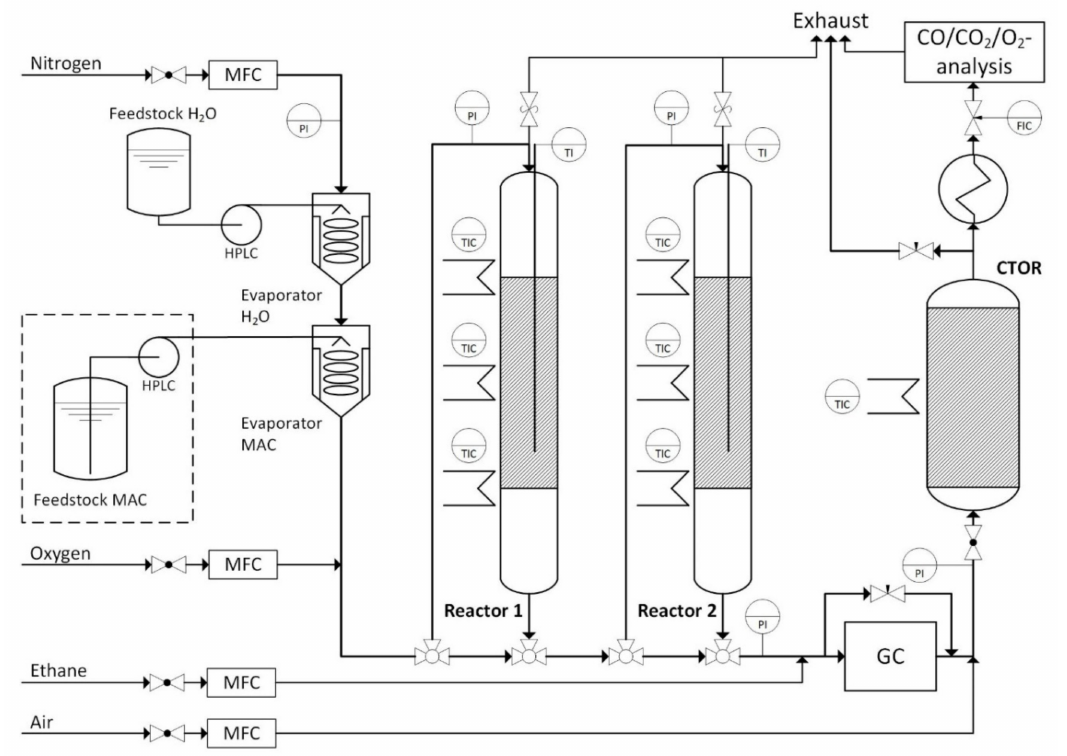
Figure 13. Simplified flow scheme of the lab scale